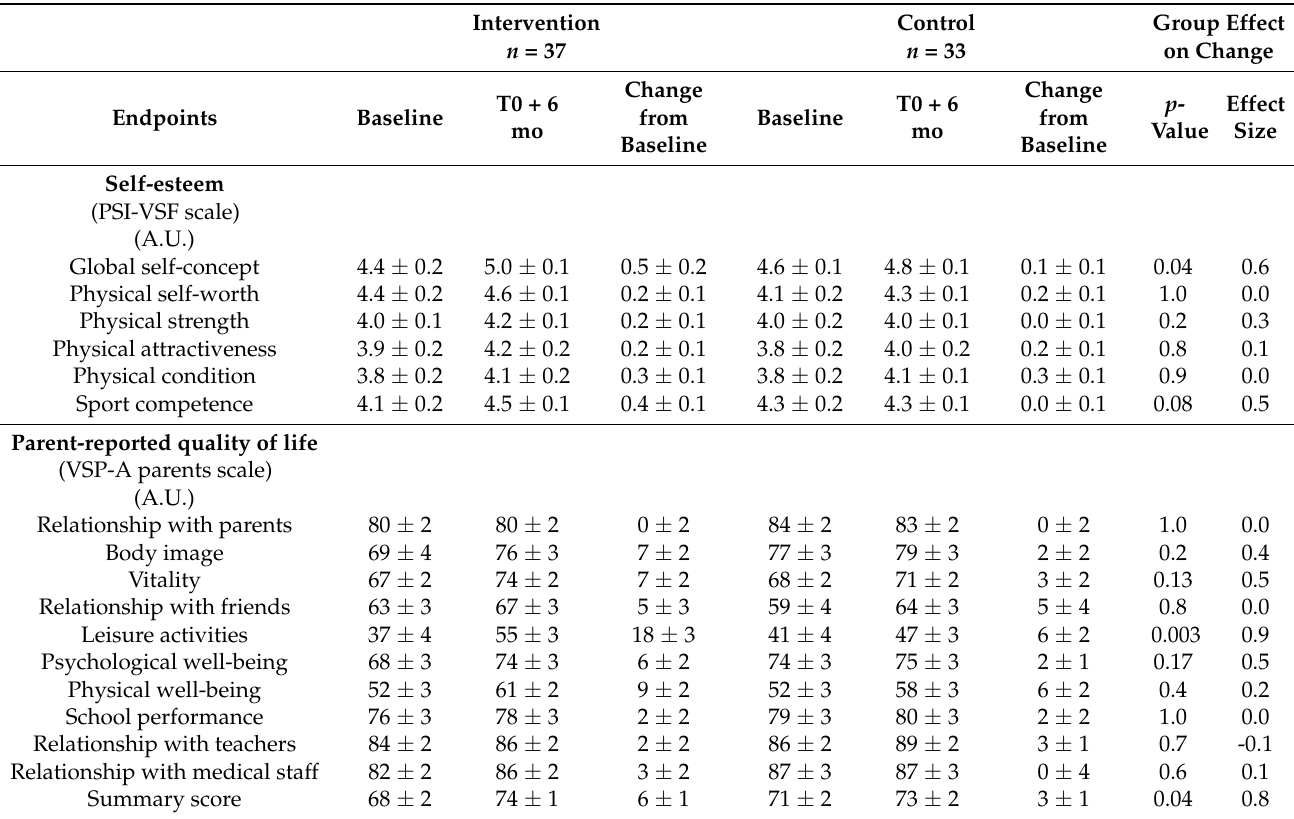
Table 4. Self-esteem and quality-of-life endpoints at six